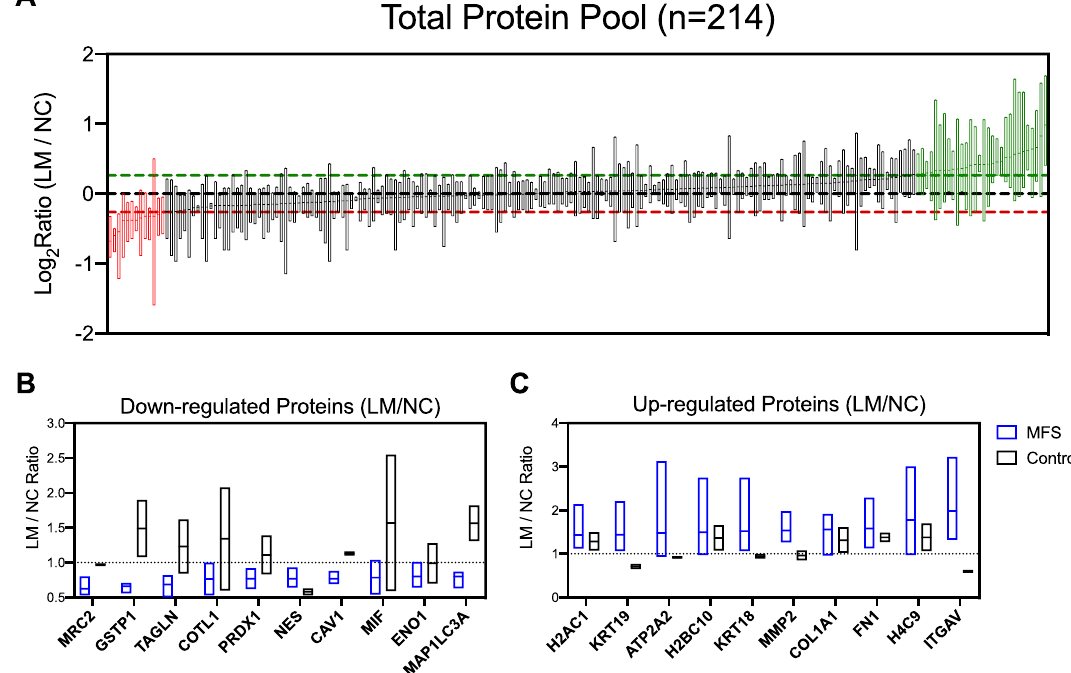
Figure 3. Single protein-level data. ( A ) Proteins with change in abundance per iTRAQ analysis. Protein expression ratios (LM/NC) for all 214 “common” proteins between iTRAQ runs displayed. Proteins with mean increase expression > 1.2 in LM (green line) highlighted in green, and increased expression in NC > 1.2 (red line) highlighted in red. Boxes depict range for n = 4 MFS samples, line depicts mean. ( B ) Top 10 most highly downregulated in LM SMC from MFS patients. ( C ) Top 10 most highly upregulated in LM SMC from MFS patients. Blue boxes depict range for MFS patients (n = 4), black boxes depict range for controls (n = 2). Lines depict